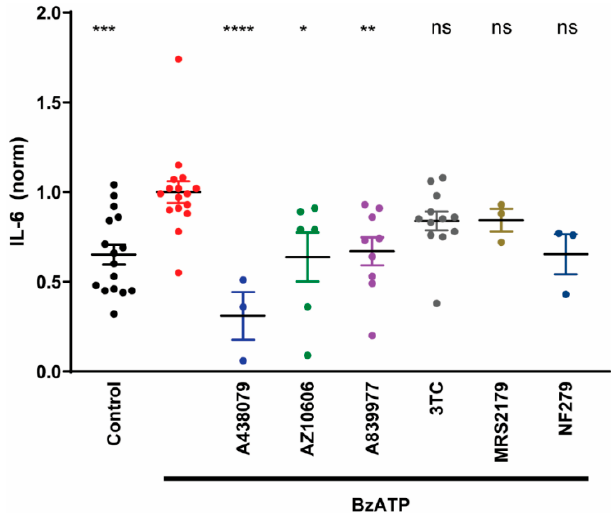
Figure 3. Pharmaceutical validation of P2X7 receptor. Exposure of ARPE-19 cells to 100 µM BzATP in isotonic solution for 30 min triggered a release of IL-6 (*** vs. Control, p = 0.0005, n = 13). In the presence of BzATP, IL-6 release was reduced by P2X7 antagonists A438079 (50 µM, **** p < 0.0001, n